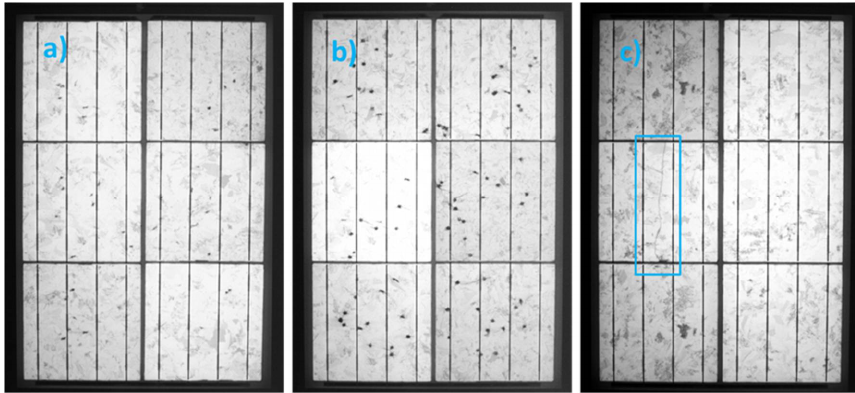
Figure 3 . Electroluminescence (EL) images at 10% short circuit current (I SC ) of trhee test modules with ( a ) few (*) or ( b ) numerous (**) micro-cracks or ( c ) with a cell crack (+). Table 2. Power output in [W] at P MPP (measured under STC conditions) of the test modules with few * and numerous ** micro-cracks or a cell crack + before and after ageing.